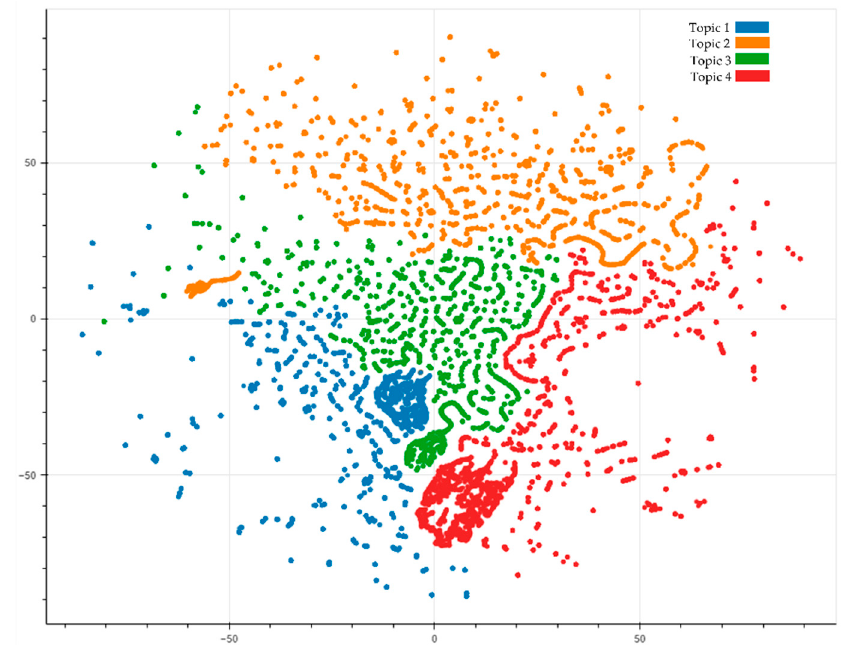
Figure 5. Visualization of the topic modeling analysis for Twitter data.